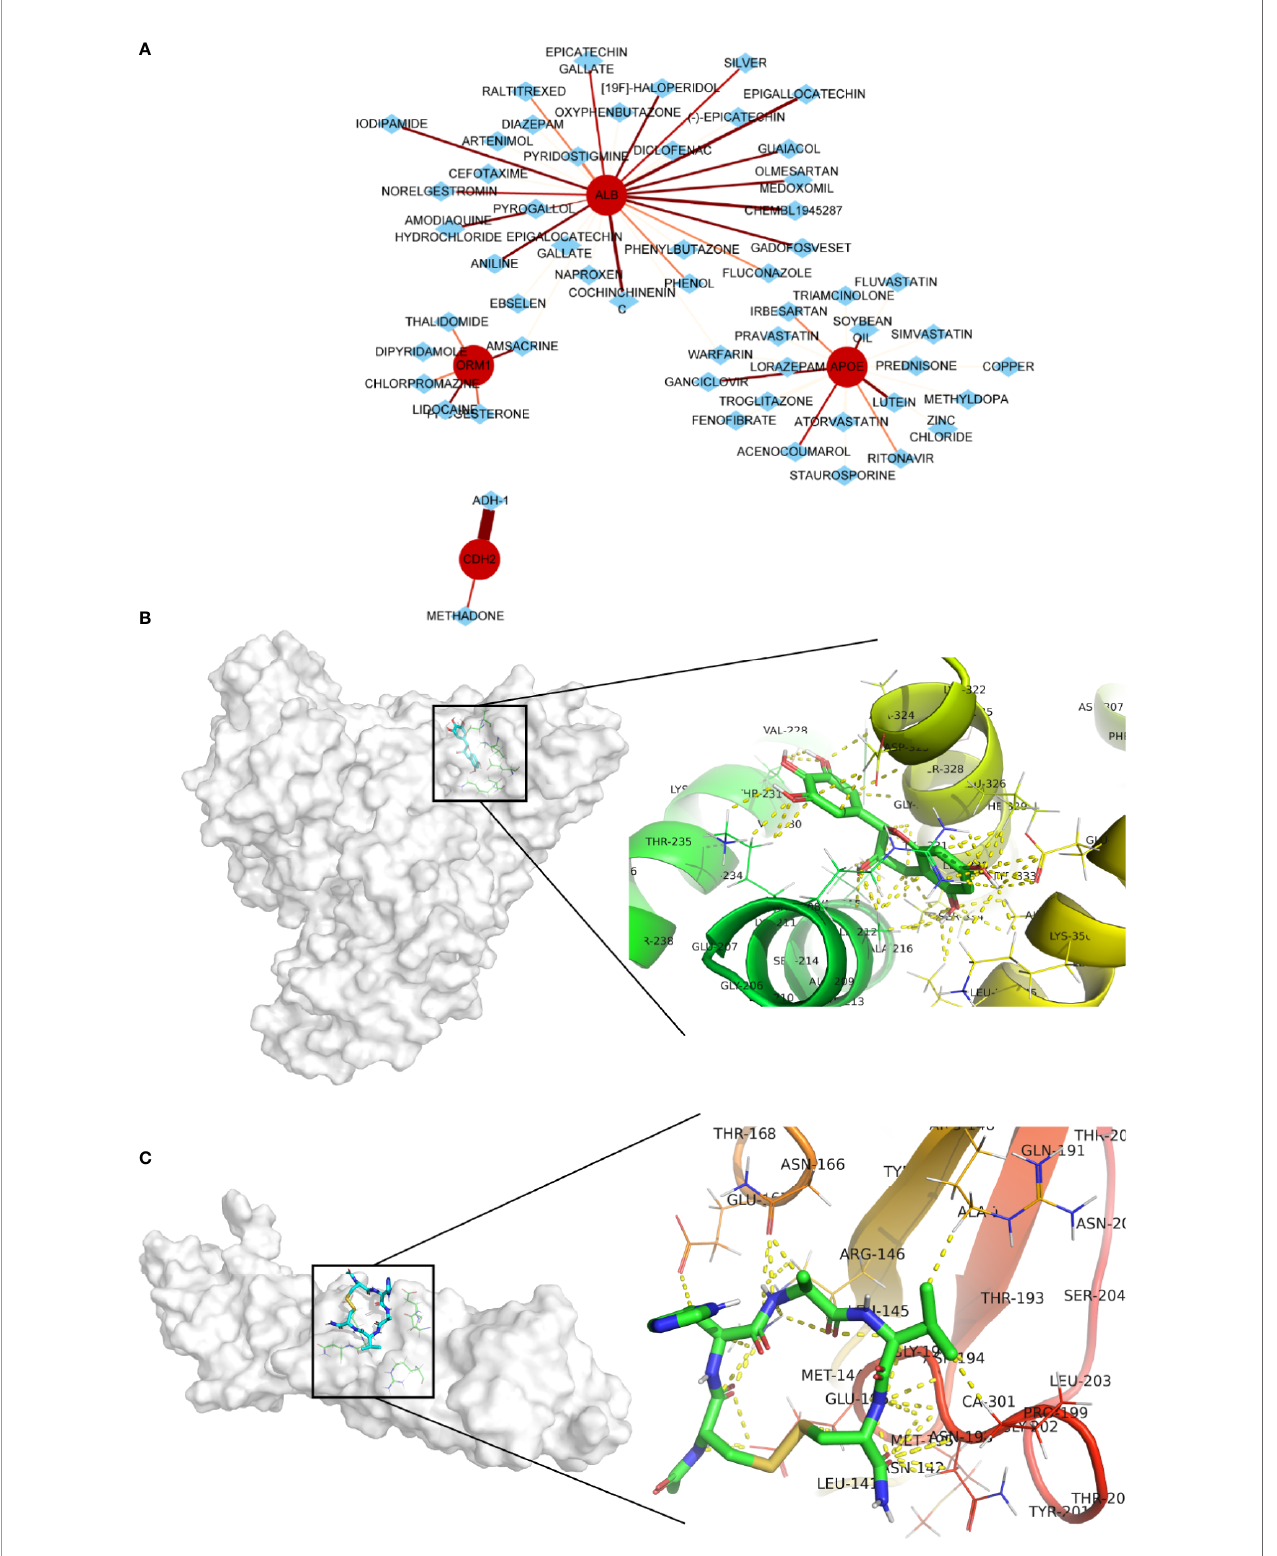
FIGURE 8 | Potential drug screening of hub genes and interactions. (A) Drug prediction using DGIdb online database; the size and color of line indicates interaction score. Protein – drug interactions between (B) ALB and epigallocatechin and (C) CDH2 and ADH-1. Yellow dot indicates any type of interactions.